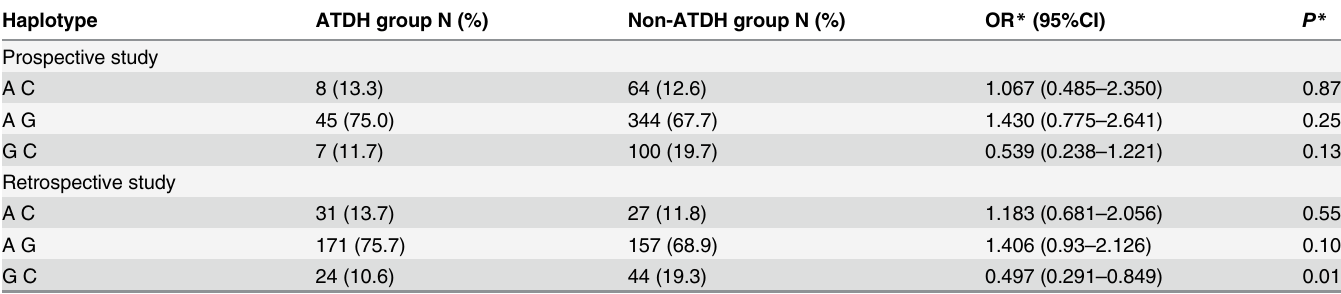
Table 3. Haplotype analysis of rs1695 and rs4147581.